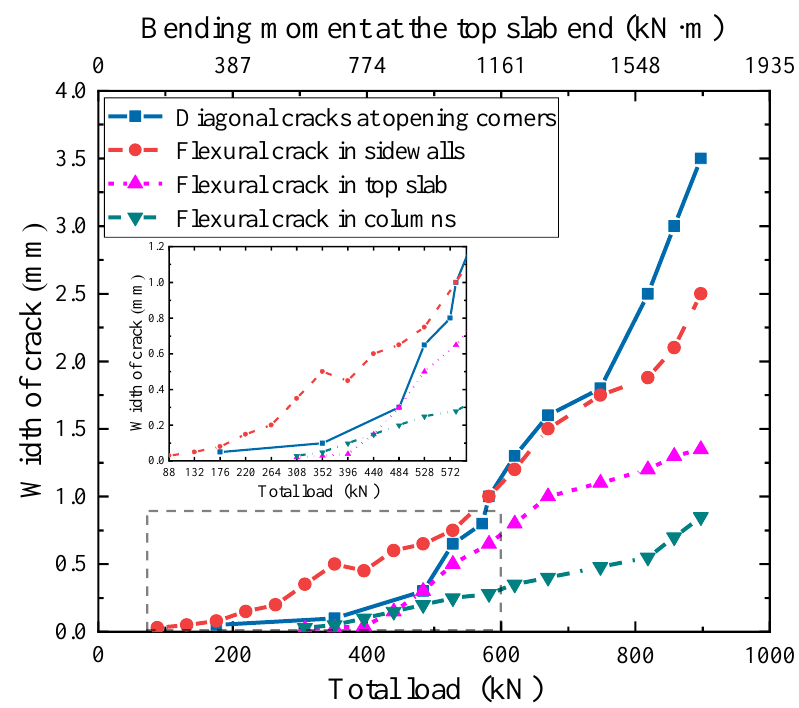
Figure 10. Load–crack width curves of the specimen.